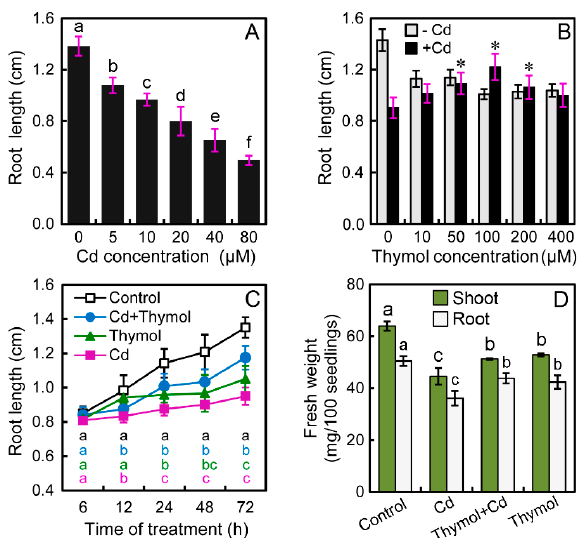
Figure 1. The effect of thymol on the growth of tobacco seedlings under Cd stress. ( A ) The roots of seedlings were treated with CdCl 2 at 0–80 μ M for 72 h for the measurement of root length; ( B ) In the presence of CdCl 2 at 20 μ M, the roots of seedlings were treated with thymol at different concentrations (0–400 μ M) for 72 h. Then the root length was measured; ( C ) The roots of seedlings were exposed to 20 μ M of CdCl 2 and 100 μ M of thymol simultaneously for 6, 12, 24, 48, and 72 h, respectively, for the measurement of root length; ( D ) The roots of seedlings were treated with water, 20 μ M of CdCl 2 , 100 μ M of thymol, alone, or their combinations for 72 h. Then the shoots and roots were harvested, respectively, for the quantification of fresh weight. Each value was represented as the mean of three replicates with SD. Different letters in ( B ) and ( D ) indicate that the mean values are significantly different between the treatments ( p < 0.05, ANOVA, LSD). Different letters in ( C ) indicate that the mean values are significantly different among four treatments at a particular point in time ( p < 0.05, ANOVA, LSD). The asterisk in ( B ) indicates that the mean value was significantly different between thymol + Cd treatment and Cd treatment alone ( p < 0.05).